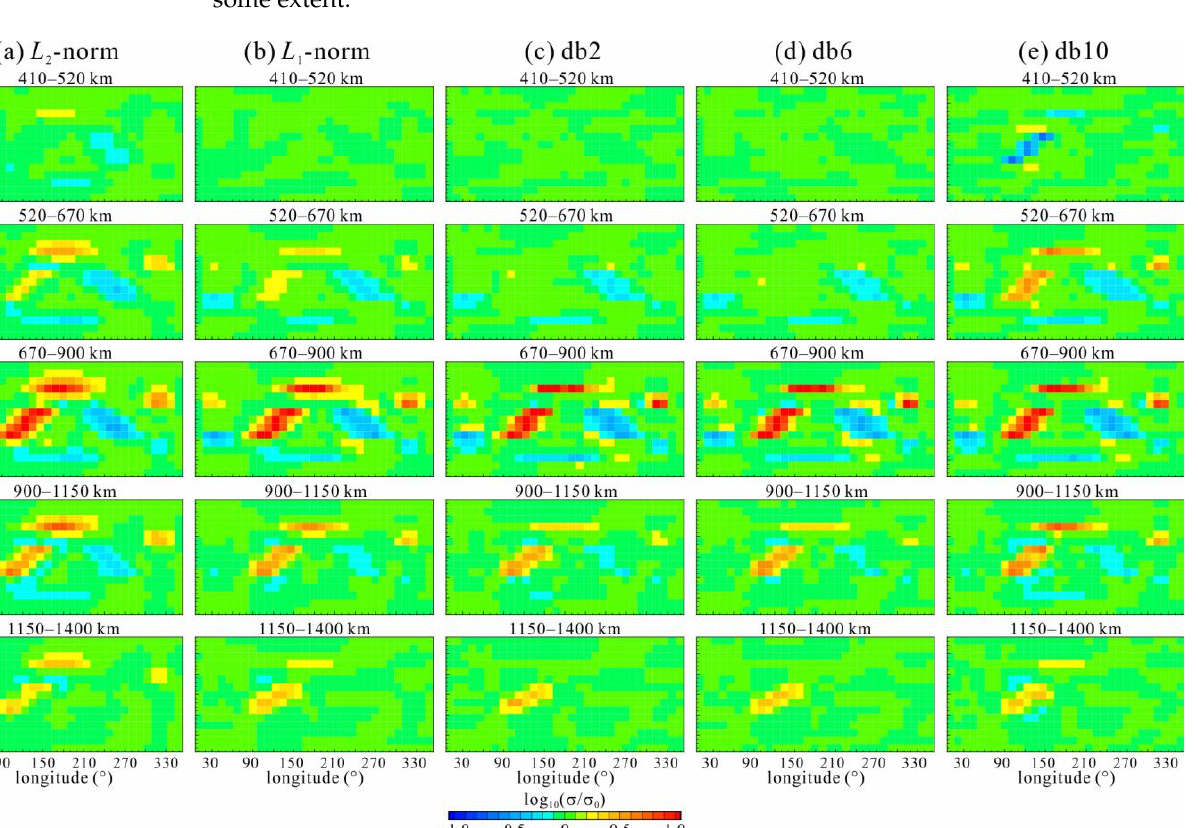
Figure 5. Inversion results of the L p -norm (a: L 2 -norm and b: L 1 -norm) and wavelet-based (c: db2, d: db6, and e: db10) inversions.